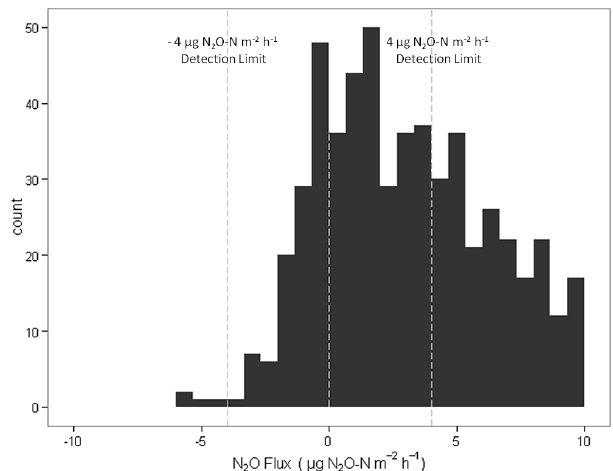
Figure 2. Frequency of all N 2 O fluxes measured from all locations excluding those above 10µgN 2 O-Nm − 2 h − 1 . The estimated zero flux detection limit of ± 4µgN 2 O-Nm − 2 h − 1 is